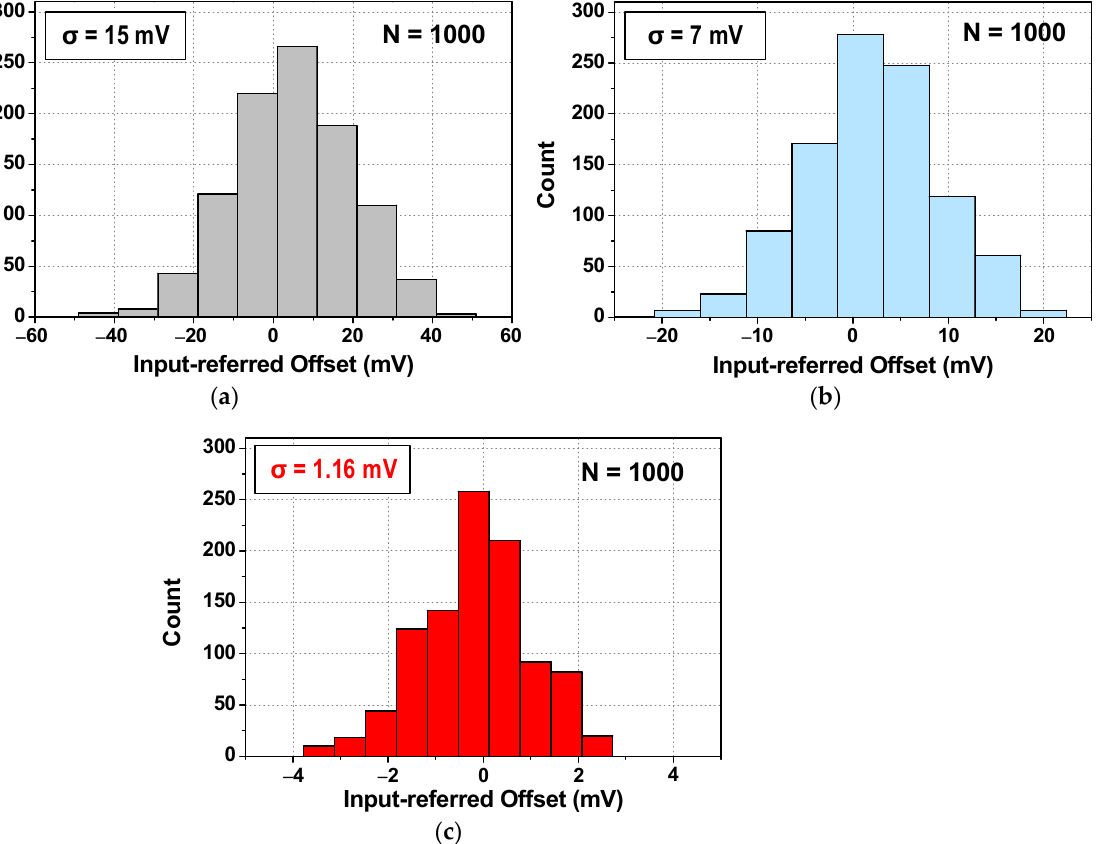
Figure 5. Monte Carlo simulation results of input ‐ referred offset mismatch. ( a ) Strong ‐ arm latch, ( b ) DA + latch, and ( c ) inverter ‐ inserted comparator (this work).